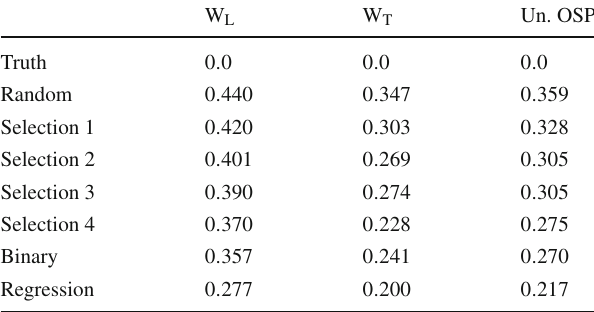
Table 4 RMSE between the the true and reconstructed cos ϑ , calcu- lated as a quantitative parameter to evaluate the performance of applied selection-criteriaandDNNtechniquesinthesemi-leptonicchannel.We evaluate RMSE on samples containing a purely longitudinally polar- ized (W L ) leptonically decaying W boson, a purely transversely polar- ized (W T ) boson and an unpolarized W boson generated in the OSP PHANTOM framework (Un. OSP). RMSE is equal to 0 in the case of